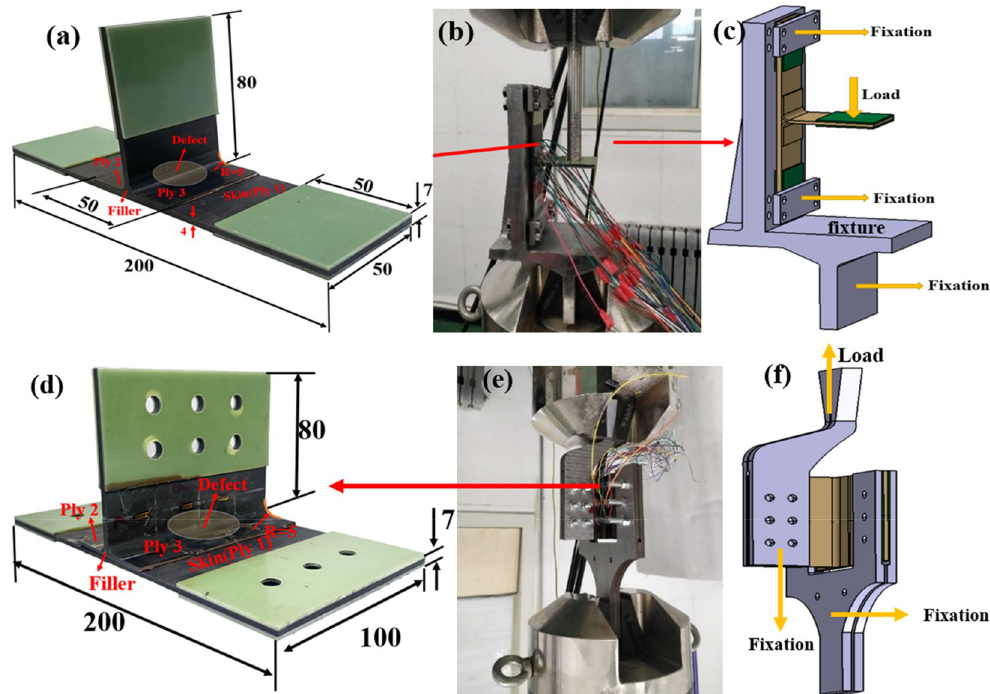
Figure 2. Schematic diagram of T-stiffened panel structure test piece and loading device: ( a ) T-lateral bend- stiffened panel dimension; ( b ) side bending test loading device; ( c ) lateral bend test geometry; ( d ) T-shear- stiffened panel dimension; ( e ) shear test loading device; ( f ) shear test